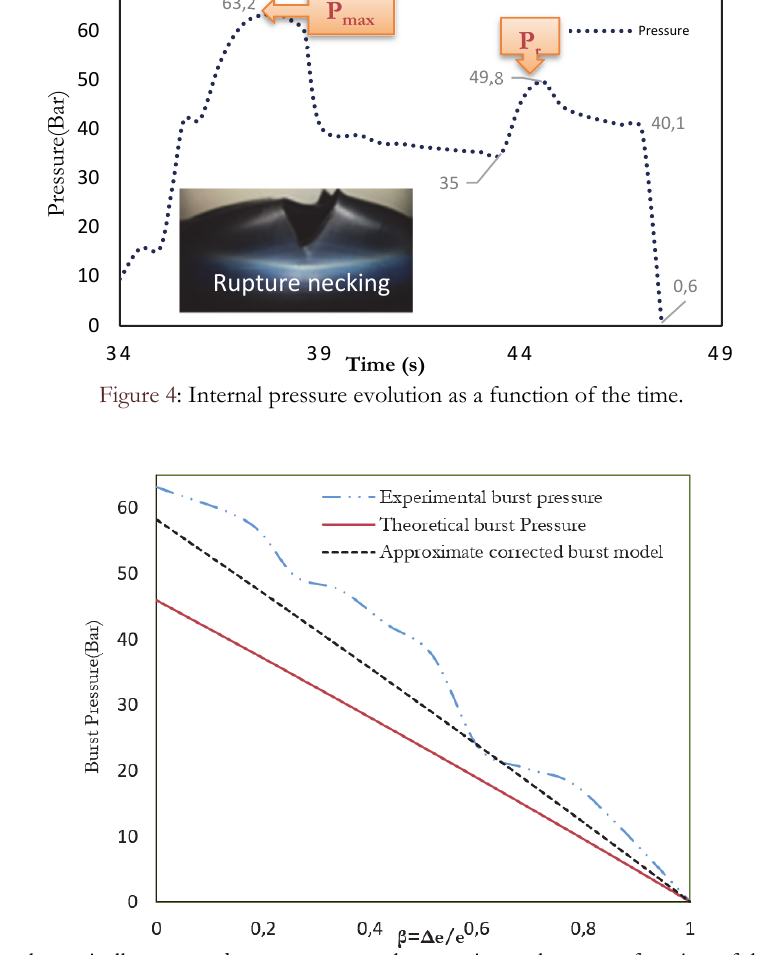
Figure 5: The theoretically corrected pressure versus the experimental one as a function of the life fraction.